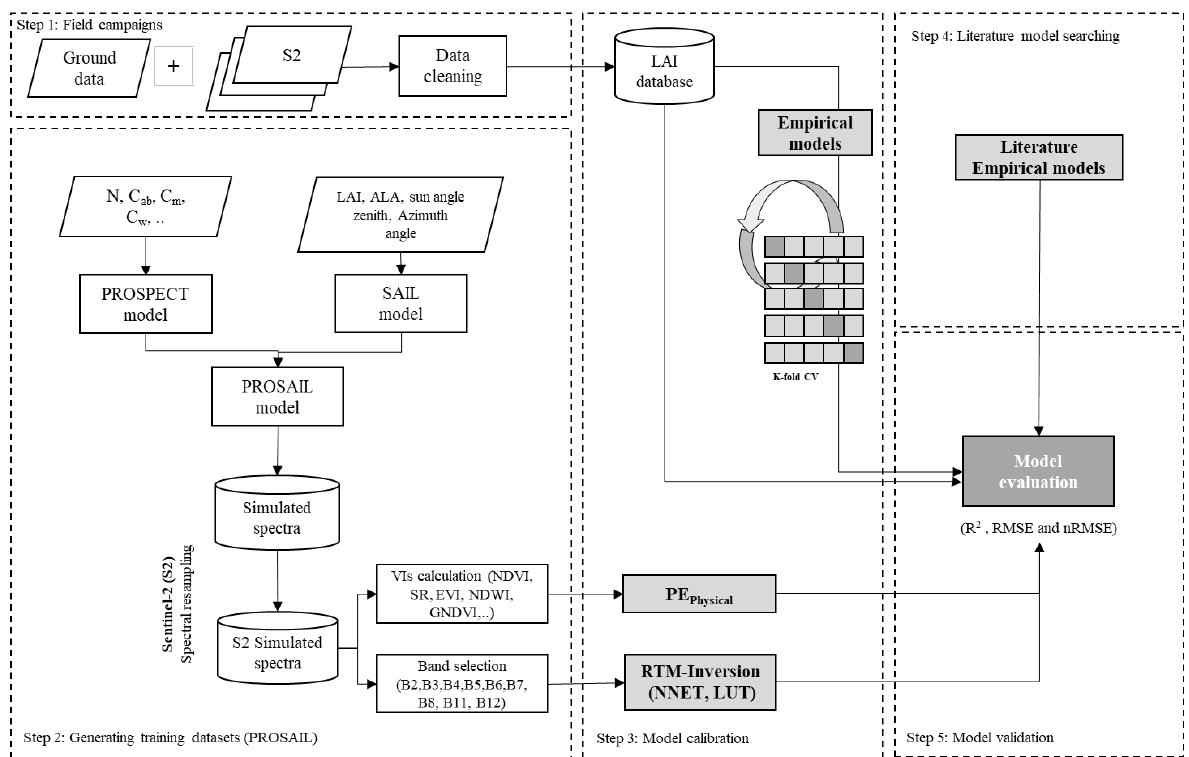
Figure 3. The general framework of the work: Step 1: field campaigns; Step 2: generating training datasets using PROSAIL; Step 3: model calibration (for the empirical model); Step 4: literature model searching, and Step 5: model accuracy assessment .